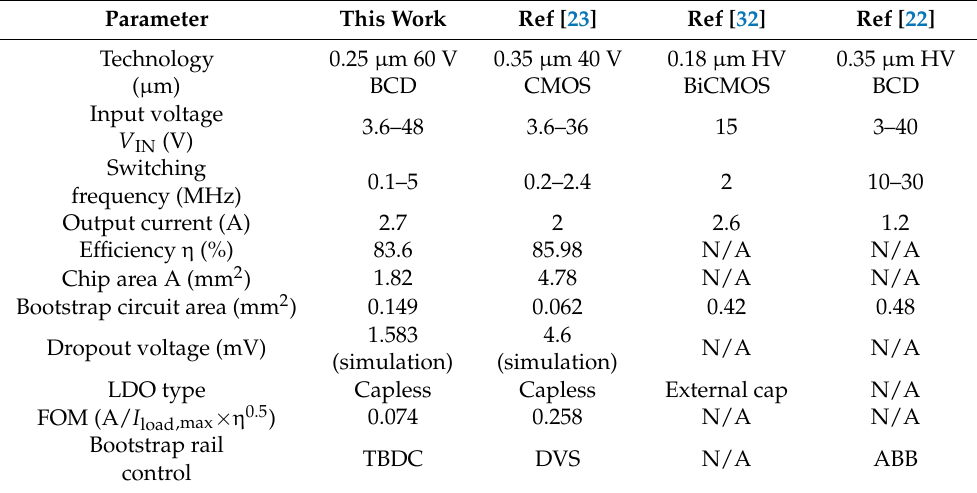
Table 1. Comparison with previously published works is shown, indicating wider input voltage, higher switching frequency, larger output current, and smaller chip area with a good FOM while maintaining the same